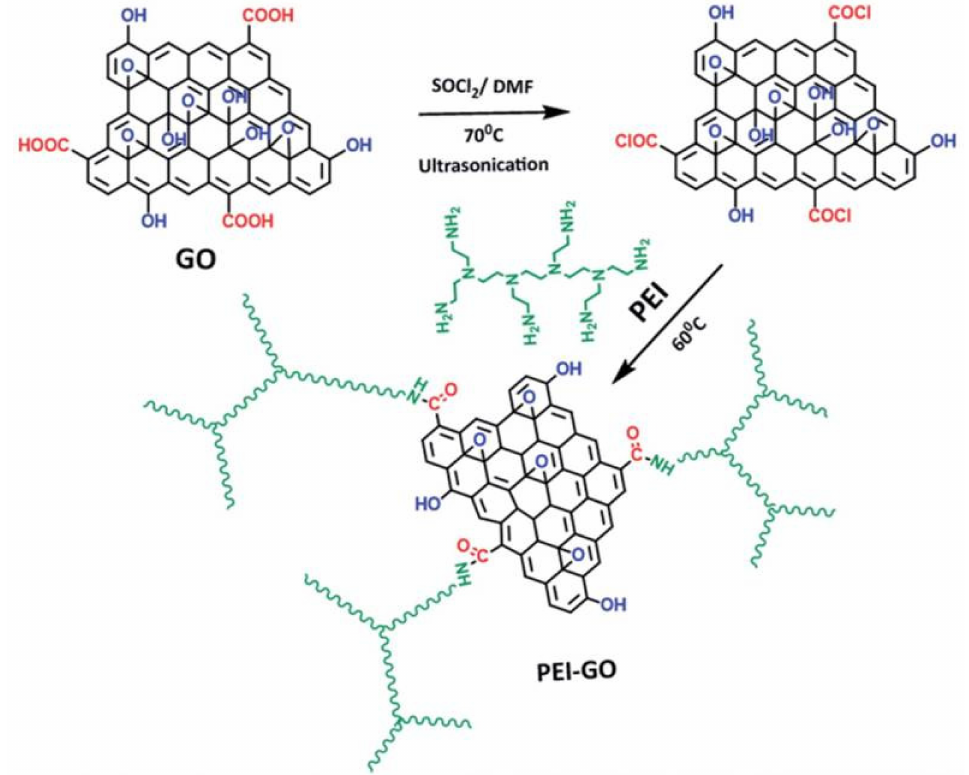
Figure 10. Schematic illustration of the synthesis of PEI-GO inhibitor [73], Reproduced with permis- sion from ref. [73]. Copyright 2020 Royal Society of